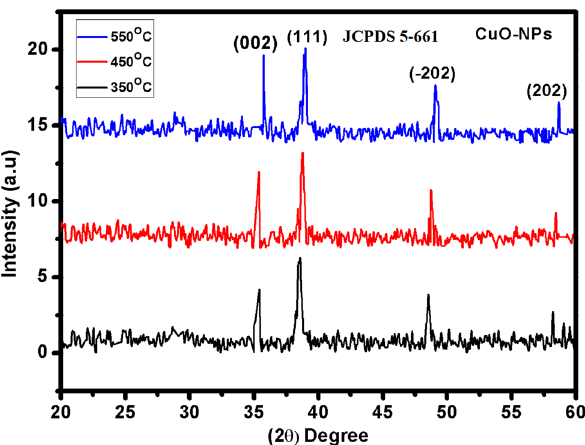
Figure 1: XRD diagram of CuO samples calcinated at 350, 450,